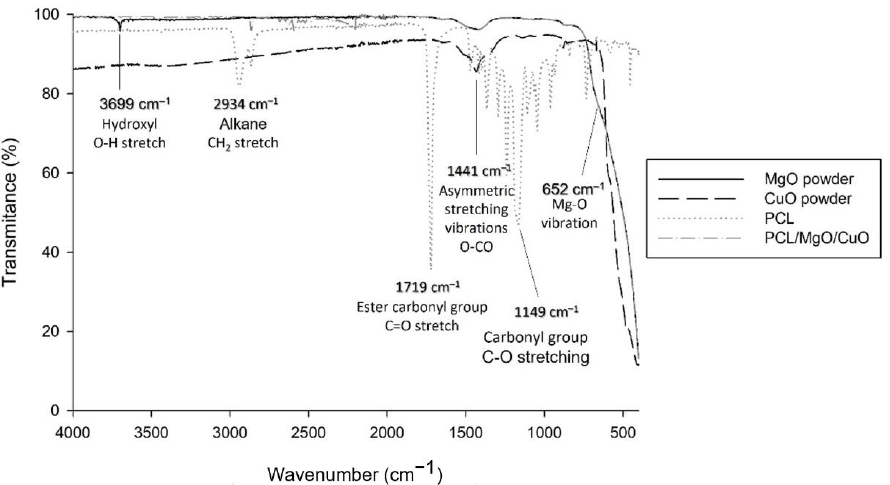
Figure 3. FTIR-ATR spectra of the MgO and CuO NPs powder and PCL electrospun meshes as controls, and PCL/MgO/CuO electrospun meshes with the main peaks identified and functional groups.